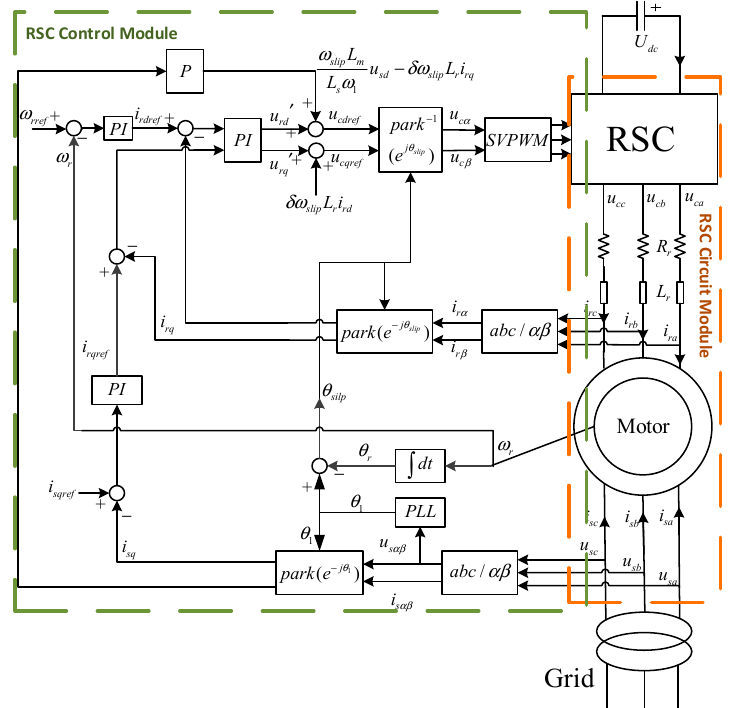
Figure 3. The structure diagram of RSC with the control system. The GSC and dc link are substituted by a dc voltage source. The orange dash line box is the circuit module of RSC, and the green dash line box is the control module of RSC.